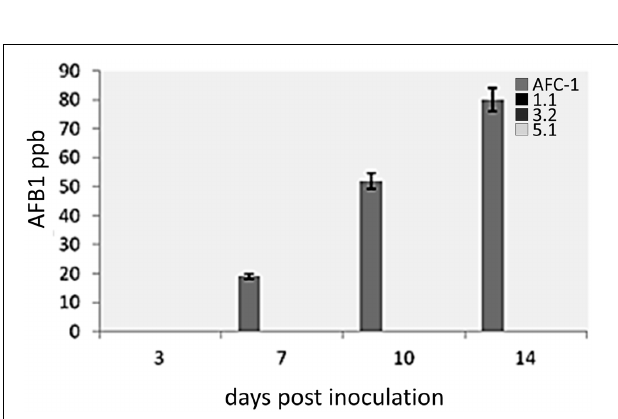
FIGURE 5 | (A) LOX activity (U/mg protein) measured as diene conjugates formation at 234mn in AFC-1 and Af lox1 deleted strains in PDB at 30 ◦ C at different days after inoculation (3–14dpi). (B) HPODE synthesis (expressed as